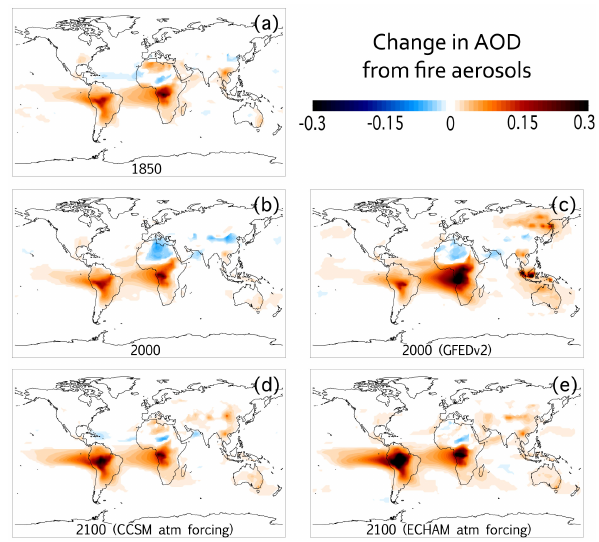
1 Fig. 6. The annual average change in AOD from fire aerosols for a) 1850 CLM3 fires, b) 2000 CLM3 2 Fig. 6. The annual average change in AOD from fire aerosols for fires, c) 2000 GFEDv2 fires, d) 2100 CLM3 fires with CCSM atmospheric forcing, and e) 2100 CLM3 3 (a) 1850 CLM3 fires, (b) 2000 CLM3 fires, (c) 2000 GFEDv2 fires, fires with ECHAM atmospheric forcing. 4 (d) 2100 CLM3 fires with CCSM atmospheric forcing, and (e) 2100 CLM3 fires with ECHAM atmospheric forcing.